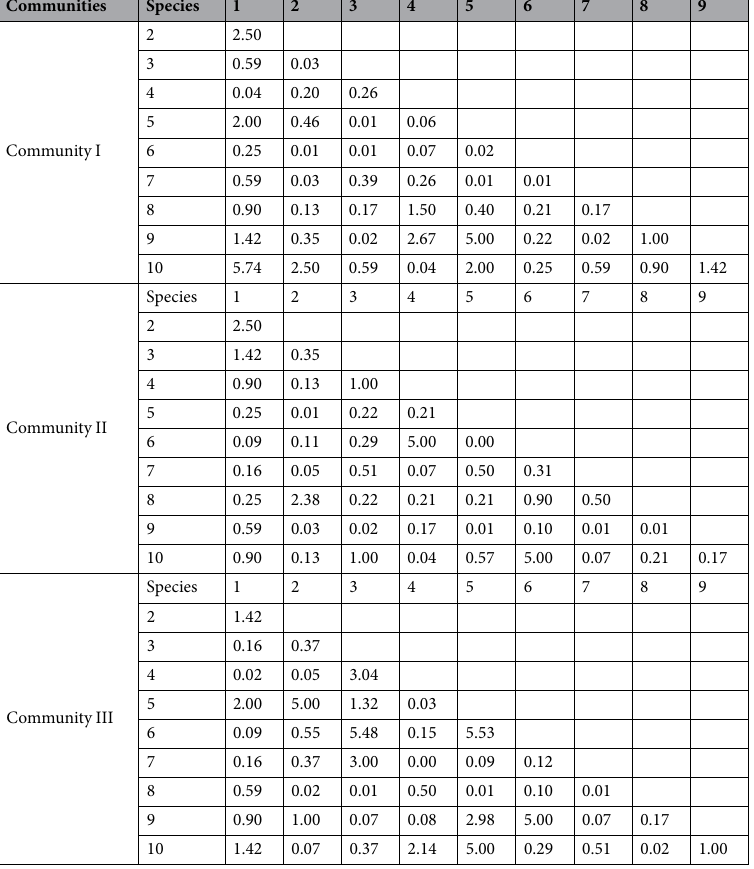
Table 5. Half matrix of inter-specific association χ 2 test among dominant species. Note: Community I: 1: Pinus tabulaeformis, 2: Quercus wutaishansea, 3: Betula platyphylla, 4: Populus davidiana, 5: Swida macrophylla, 6: Lacquer tree, 7: Betula albosinensis, 8: Pyrus betulaefolia, 9: Platycladus orientalis, 10: Cornus controversa; Community II: